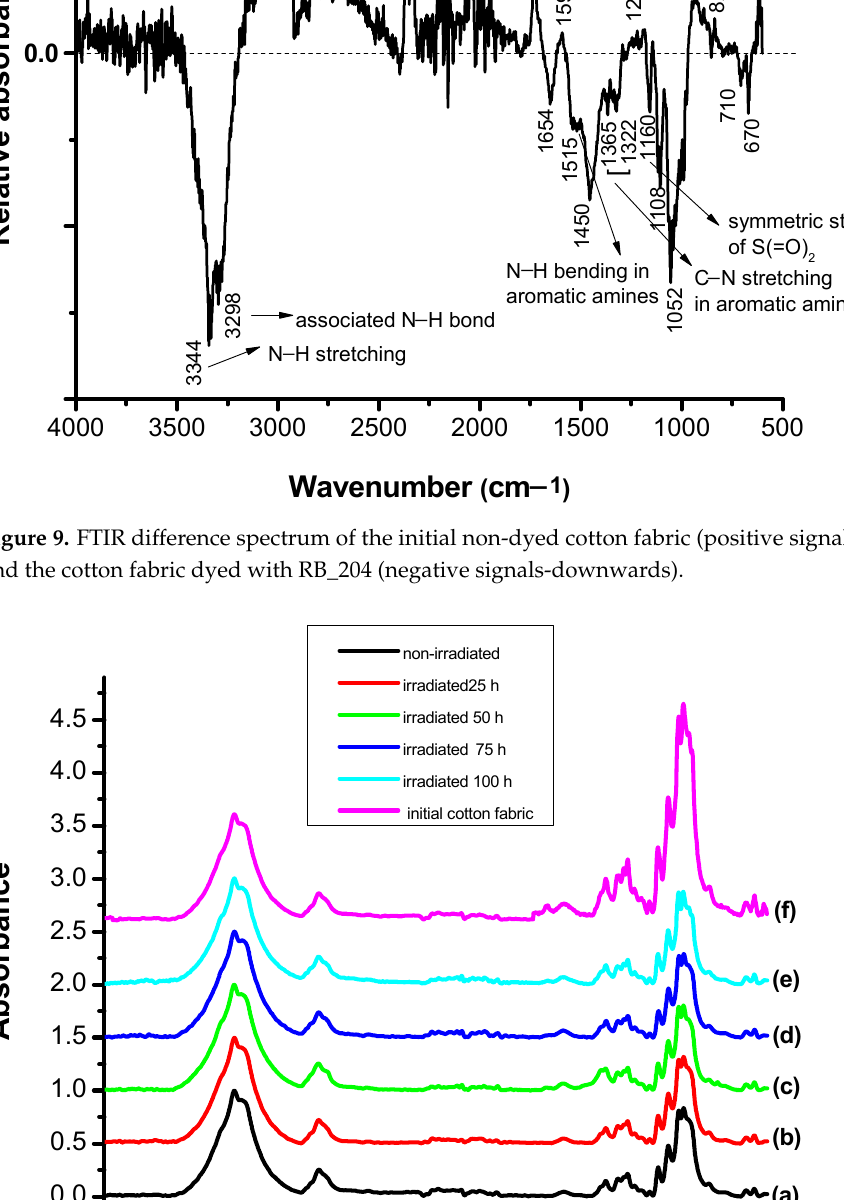
Figure 10. FTIR spectra of: ( a ) initial RB_204 dyed cotton fabric; ( b ) RB_204 dyed cotton fabric ir-